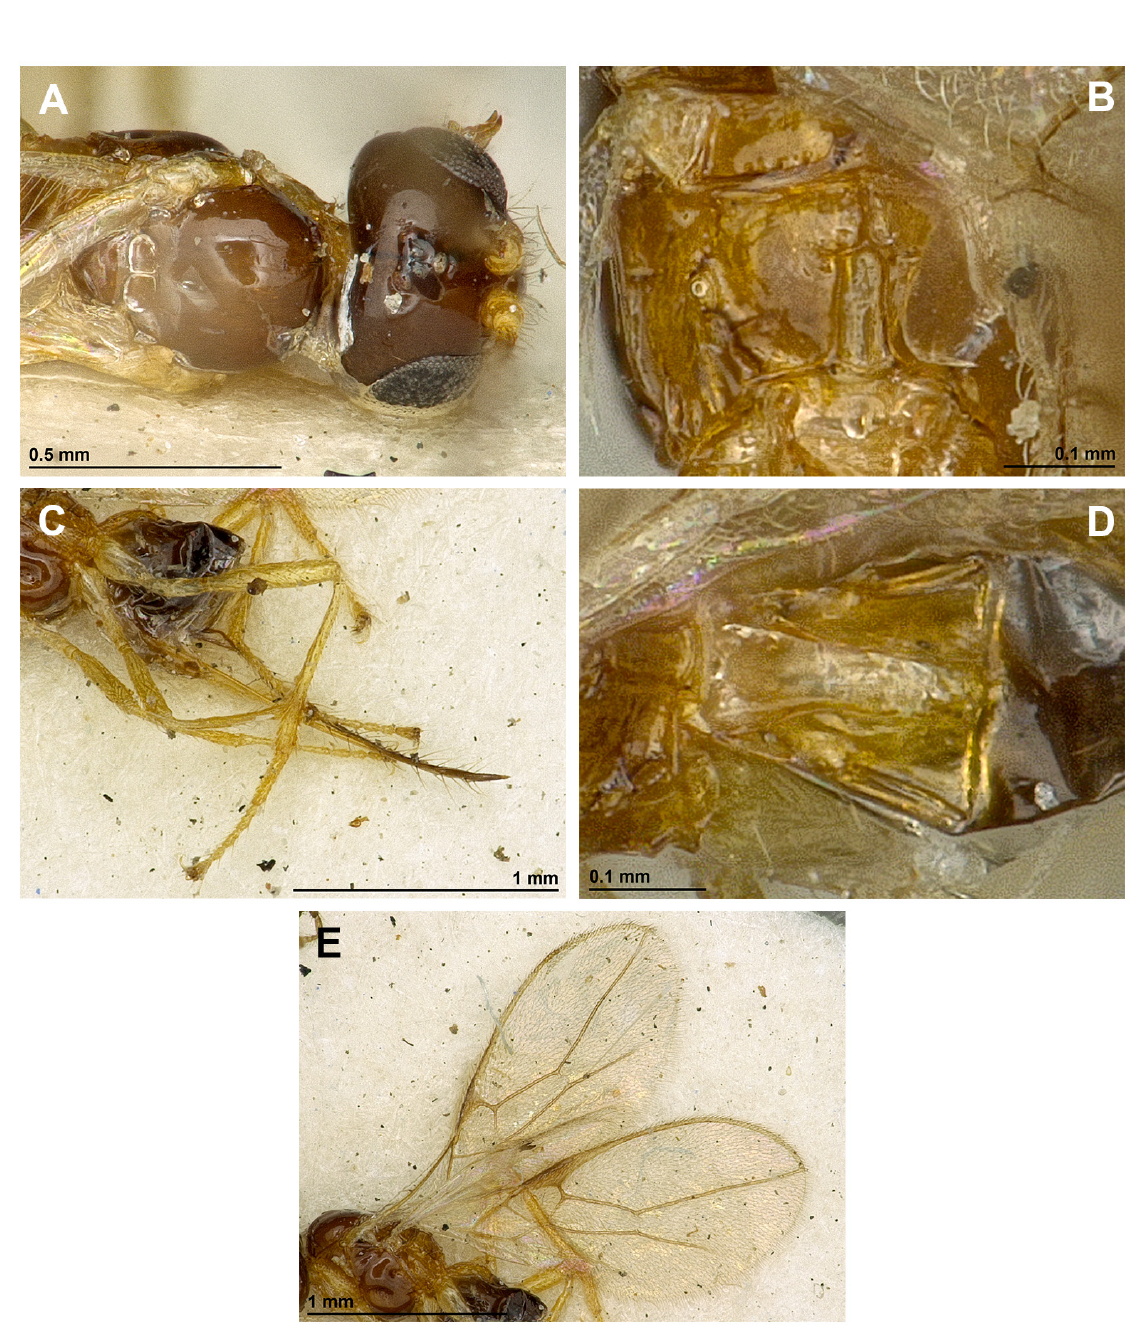
Fig. 4. Asobara apicalis Fischer, 2003, ♀, holotype (ZSSM). A . Head and mesoscutum, dorsal view. B . Propodeum, dorsal view. C . Hind leg, metasoma and ovipositor, lateral view. D . First metasomal tergite, dorsal view. E . Fore and hind